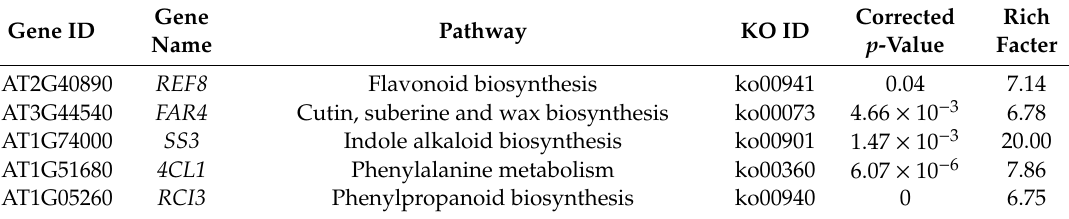
Table 2. Significant representative di ff erentially expressed genes (DEGs) involved in KEGG enrichment during the dedi ff erentiation stage (DWCIM7 vs. DCIM7, DCIM7 vs. RCIM7, DWCIM7 vs.